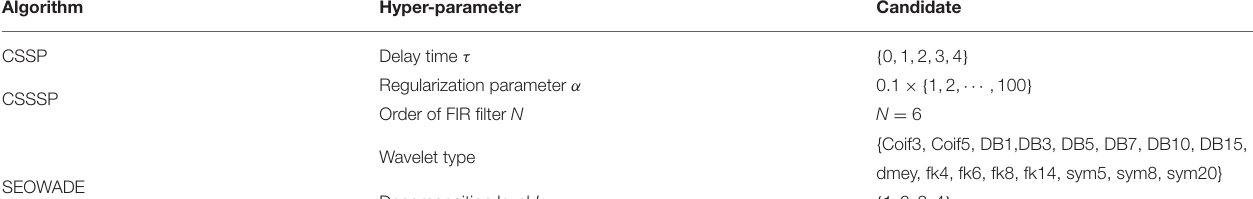
TABLE 2 | Candidate sets of the hyper-parameters for each algorithm. Algorithm